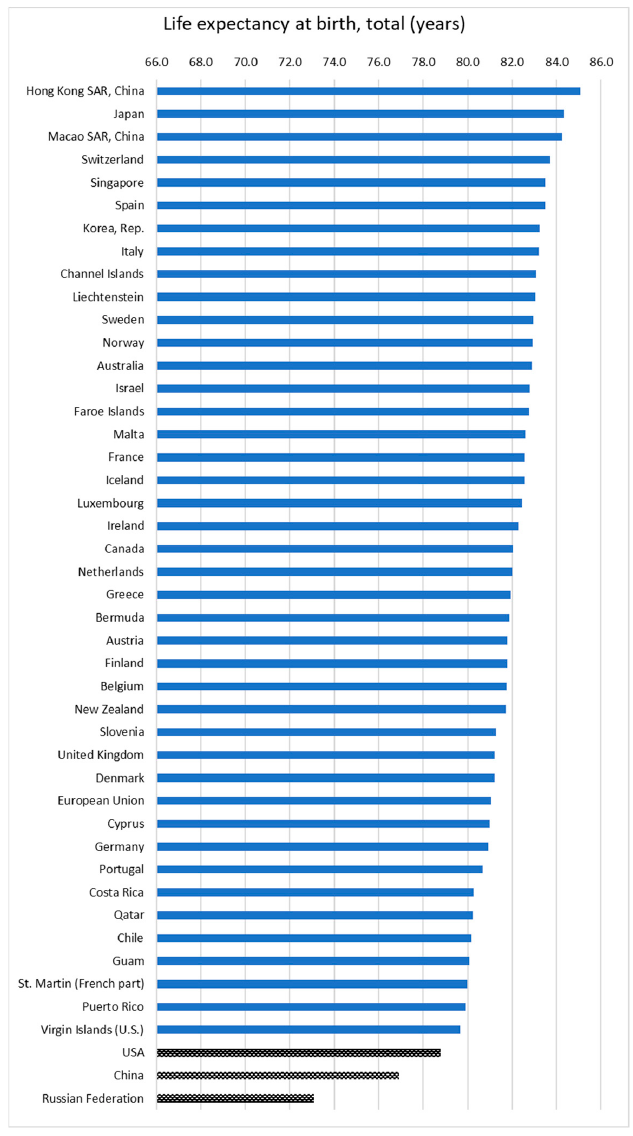
Figure 2. Countries and regions of the world with the highest life expectancy (about 80 years or more) and the Russian Federation. Source: developed by the authors based on data from the World Development Indicators [31].